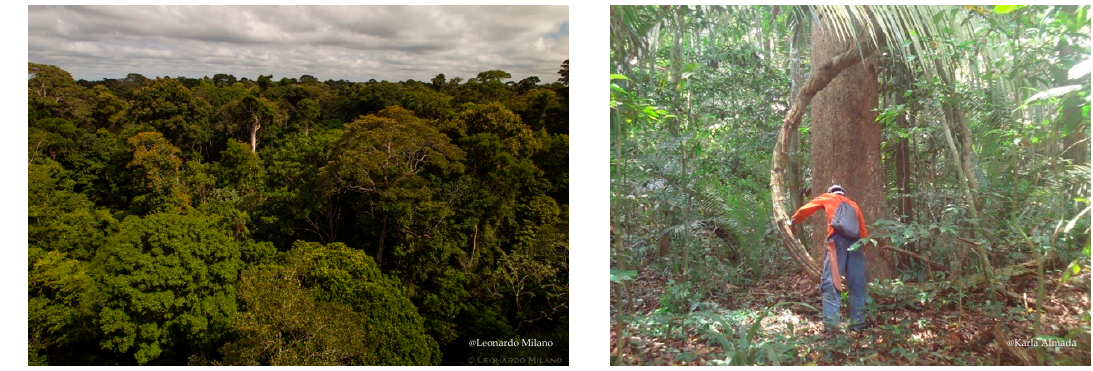
Figure 2. Dense tropical forest in Tapajós National Forest.